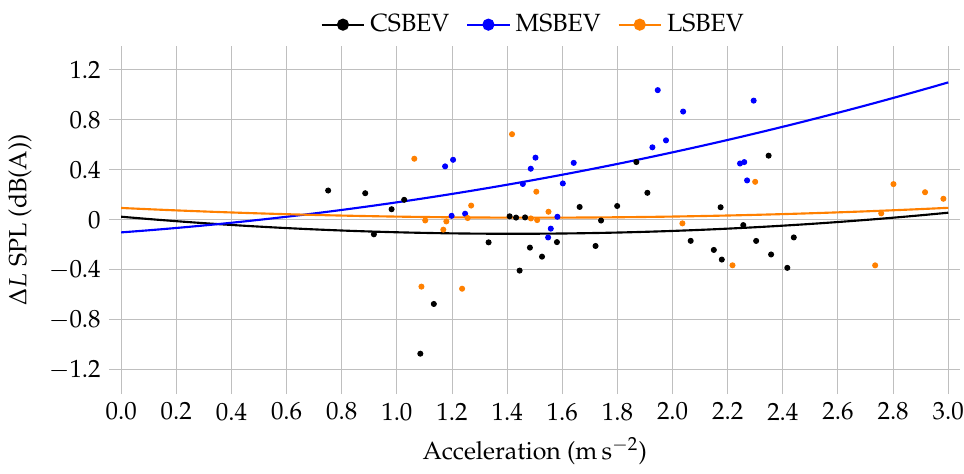
Figure 15. Accelerated noise behavior of the tire 255B on three different